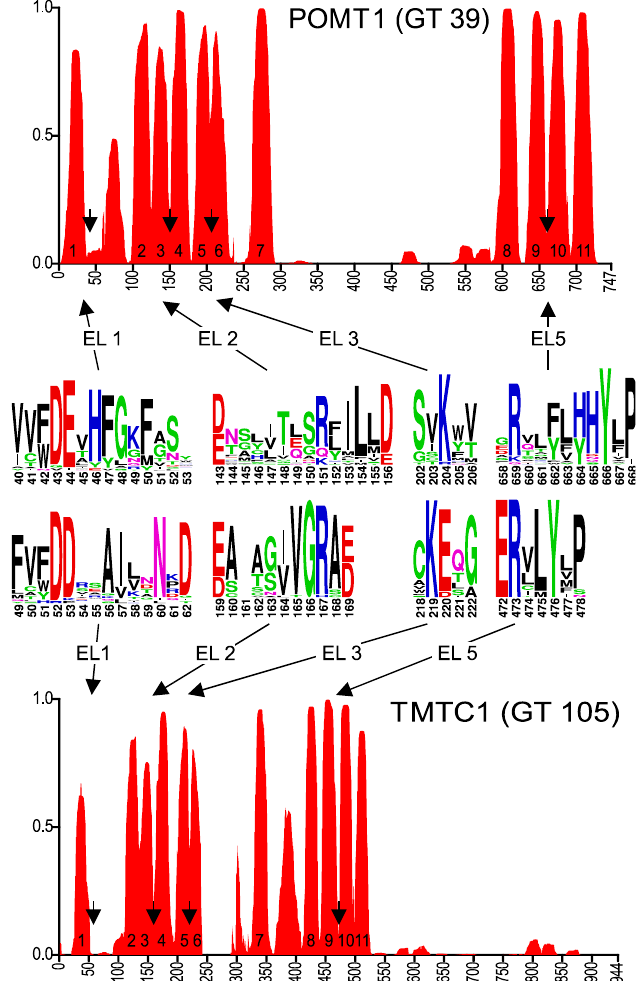
Figure 4. Predicted membrane topology and amino acid conservation of human POMT1 and TMTC1. Transmembrane domain prediction was carried out using the algorithm PolyPhobius, as described in experimental procedures. The position of the predicted extracytoplasmic loops EL1, EL2, EL3 and EL5 is indicated by arrows and amino acid conservation in these loops is shown in the sequence logos. The topology prediction of POMT can perfectly be aligned with STT3 and DPY19, with the conserved motifs at identical positions, although two TMDs less are predicted in the middle part